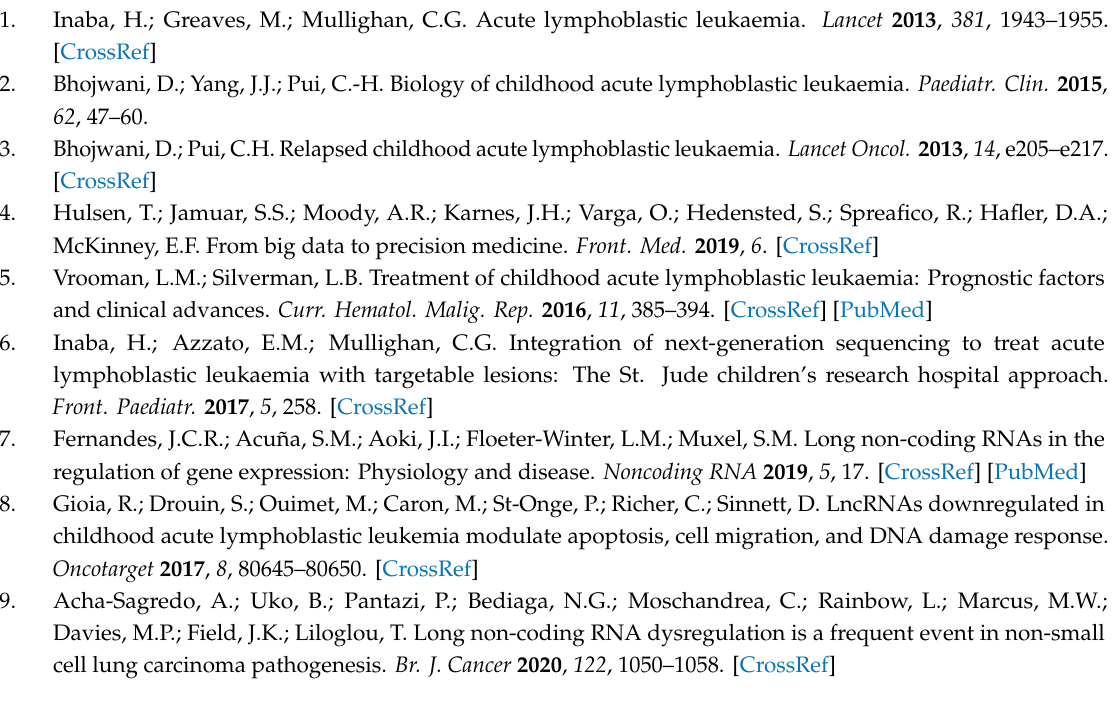
Figure S1: lncRNAs expression level and library composition, Figure S2: Distribution of lncRNAs’ fold change (FC) among quartiles. lncRNAs extracted with PCA are reported in blue, while lncRNAs not extracted with PCA are reported in red. Figure S3: Gene expression profiling of 30 di ff erential lncRNAs. Heatmap with hierarchical clustering shows the gene expression level, normalized by upper quartile (UQUA) approach, of 30 di ff erential lncRNAs in B–ALL, Table S1: The genomic position of the (not overlapping) lncRNA–mRNA pairs, according to the GhCh37.p13. Following each lncRNA is reported its co–expressed mRNAs, Table S2: Functional roles of the 30 lncRNAs based on their perfect correlations (lncRNA–mRNAs) with mRNAs membership of the 4 KEGG disease associated pathways such as “Hematopoietic cell lineage “, “Pathways in cancer”, “Acute myeloid leukaemia, AML”, “Chronic myeloid leukaemia, CML”. Only lncRNAs grouped in clusters share the same co–expressed